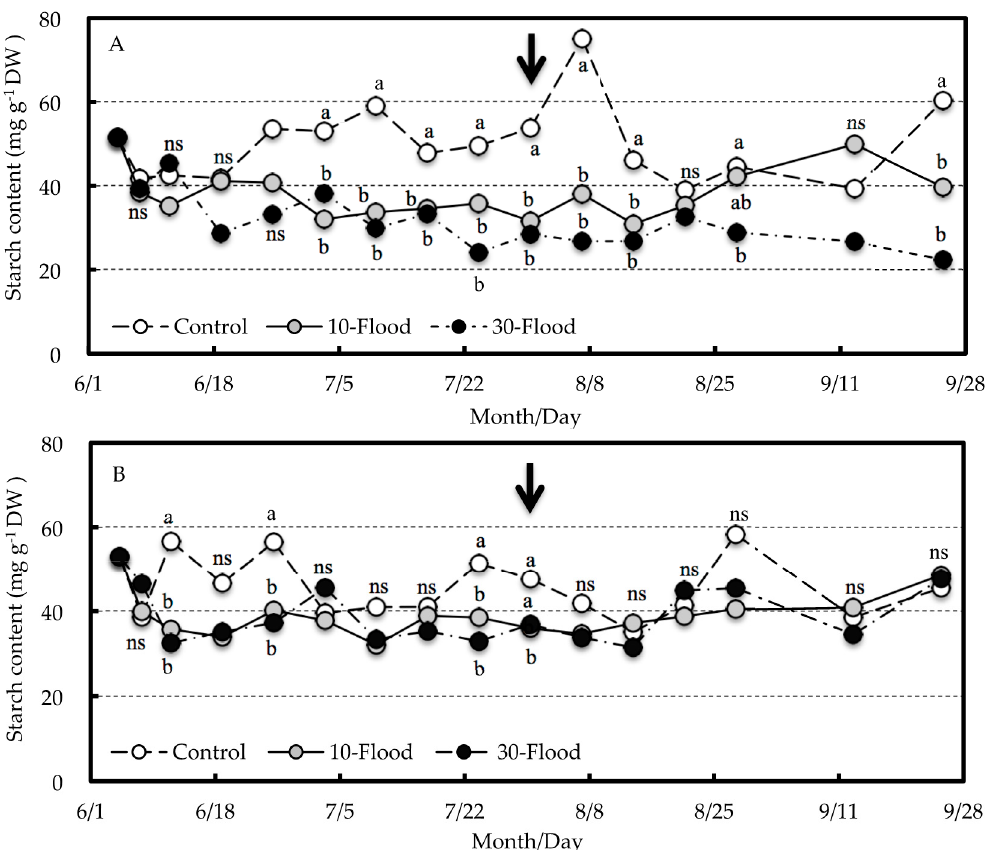
Figure 1. Changes in starch content of roots in mango grafted trees ( A ) and seedlings ( B ) during and after treatments. Different letters in the figures indicate significant differences at p = 0.05 by Fisher’s LSD, and ns indicates no significant difference among the treatments ( n = 5). Arrow indicates the end of the treatments.